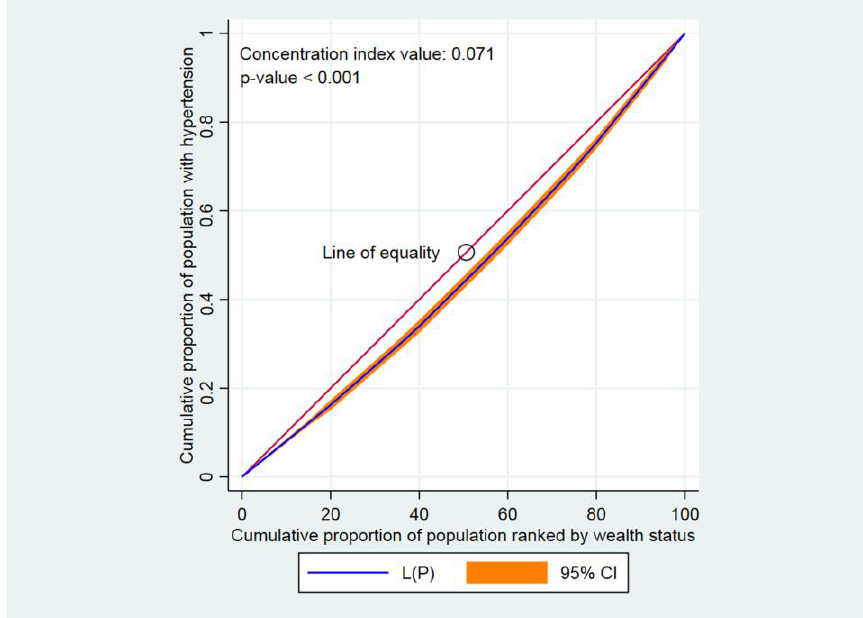
Figure 2. Concentration curve for hypertension. Here, CI denotes confidence interval.